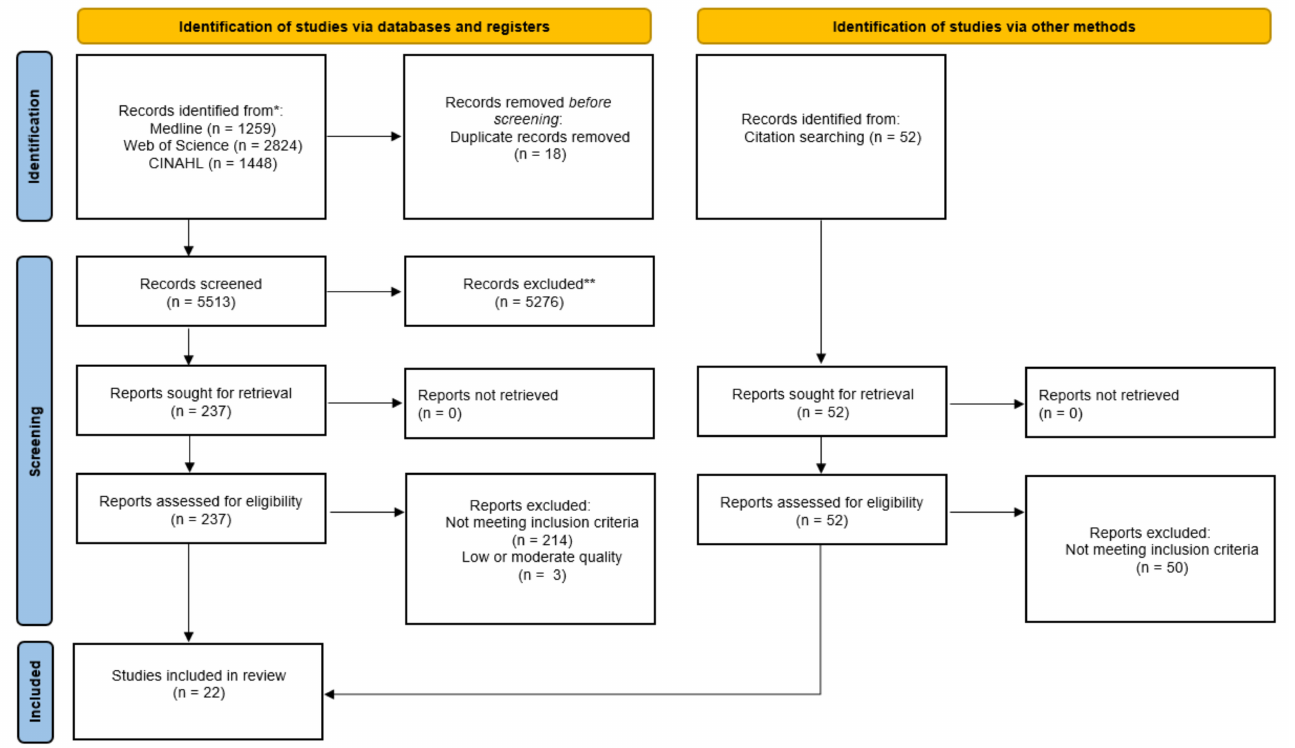
Figure 1. PRISMA 2020 flow diagram showing the selection process of studies on mortality, morbidity and health-related outcomes of informal caregivers compared to